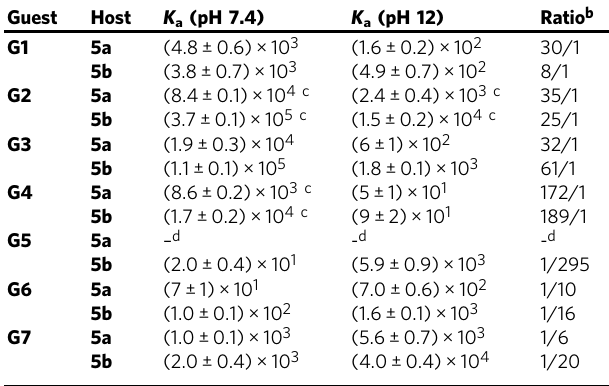
Table 1 Association constants ( K a , M − 1 ) of naphthotubes 5a and 5b with G1 – G7 in phosphate buffer (50 mM, pH = 7.4 or 12, H 2 O/D 2 O = 9/1) at 298 K as determined by 1 H NMR titrations a